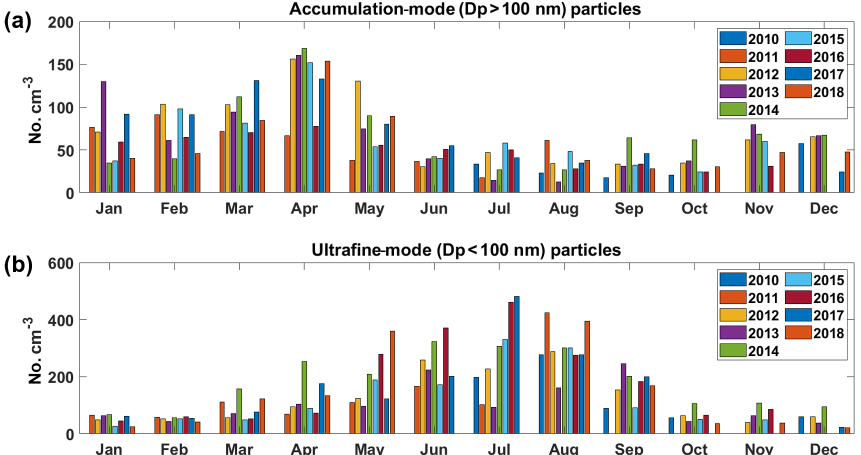
Figure 4. Monthly mean accumulation-mode (a) and ultrafine-mode (b) number concentration (no. cm − 3 ) measured at VRS from 2010 to 2018. Note the difference in the scale of the y axis for each